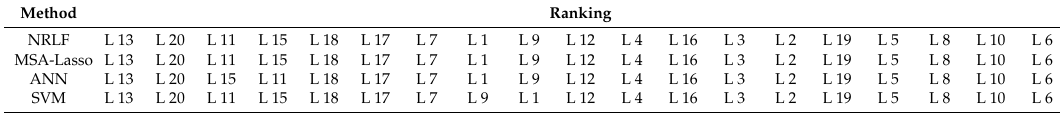
Table 9. Ranking of security indices in the base load condition of the IEEE 14-bus system. Method